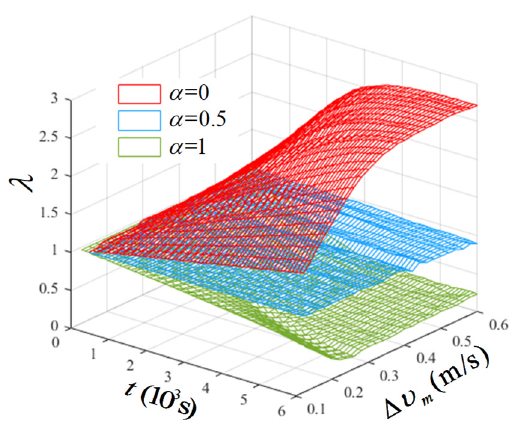
Figure 7. Fraction of vehicles and aircraft passing through the intersection under different safety safety sensitivities.